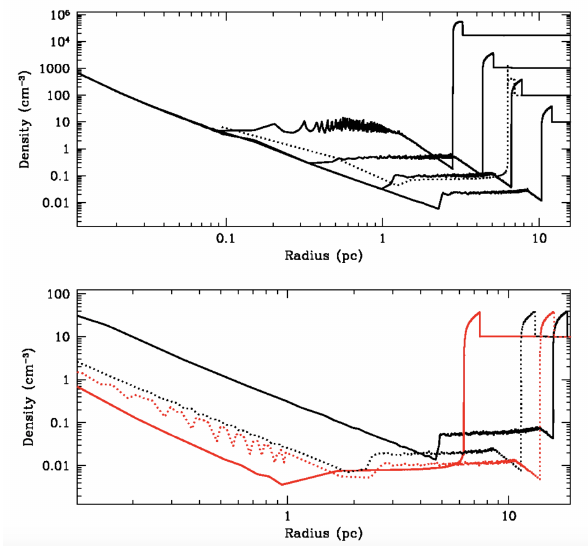
Figure 8. Density profile produced by a star wind as a function of the distance from the central object. The R − 2 profile characterizes the region where the wind freely streams, which is separated from the shocked wind (with nearly constant density) by the termination shock. Top panel: the impact of different values of the ISM density on the termination shock is shown. For all the curves, it is assumed ˙ M = 10 − 5 M (cid:12) yr − 1 and v w = 10 3 kms − 1 , while the ISM density varies from 10 to 10 4 cm − 3 , with the termination shock moving to smaller distances when the density increases. Bottom panel: for a fixed ISM density n ISM = 10cm − 3 , the impact of different ˙ M and v w is shown. Black-solid: ˙ M = 10 − 4 M (cid:12) yr − 1 and v 3 kms − 1 ; red-solid: ˙ M = 10 − 6 M (cid:12) yr − 1 and v 3 kms − 1 ; w = 10 w = 10 black-dotted: ˙ M = 10 − 5 M (cid:12) yr − 1 and v w = 500kms − 1 ; red-dotted: ˙ M = 10 − 5 M (cid:12) yr − 1 and v w = 2 × 10 3 kms − 1 . From [102]. ©AAS. Reproduced with